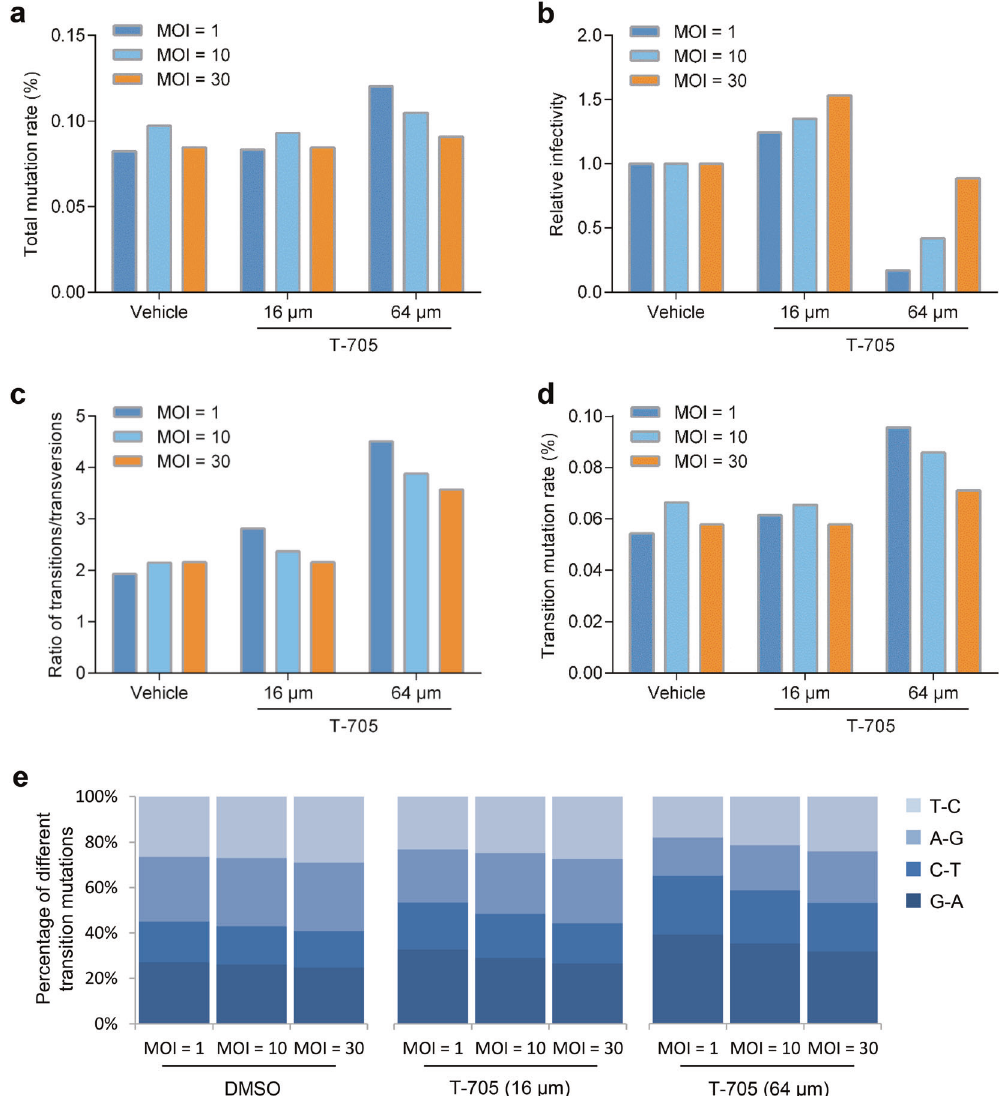
Fig. 2 Infectivity and mutation analysis of SFTSV in cell culture supernatant from cells infected with different MOIs of SFTSV. Vero cells were infected with SFTSV strain HNXY2017-66 at MOIs of 1, 10, and 30, and treated with vehicle or different concentrations of T-705. At 24 h post infection, the cell culture supernatant was collected. SFTSV genome in the supernatant was extracted and subjected to NGS analysis. Total mutation rates ( a ), ratios of transitions/transversions ( c ), transition mutation rates ( d ), and percentages of different transition mutations ( e ) were calculated. Viral titer and viral genome copy number in the supernatant were also measured, and relative viral infectivity (Viral titer/viral genome copy number) is shown ( b